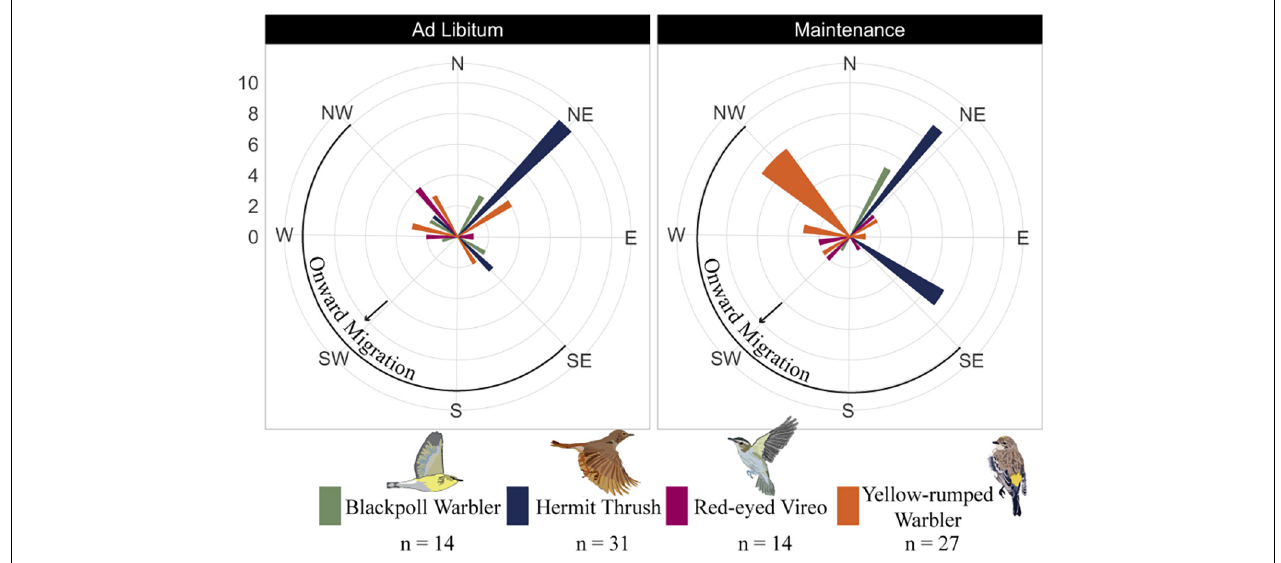
FIGURE 7 | Departure directions for fall-migrating Blackpoll Warblers (green), Hermit Thrushes (blue), Red-eyed Vireos (pink), and Yellow-rumped Warblers (yellow) fed ad lib or at maintenance levels. Departure decisions (shaded directions are onward, unshaded directions are reverse) were not influenced by feeding treatment, and the majority of birds departed in a reverse migratory direction to the north from their stopover on Block Island, RI, United